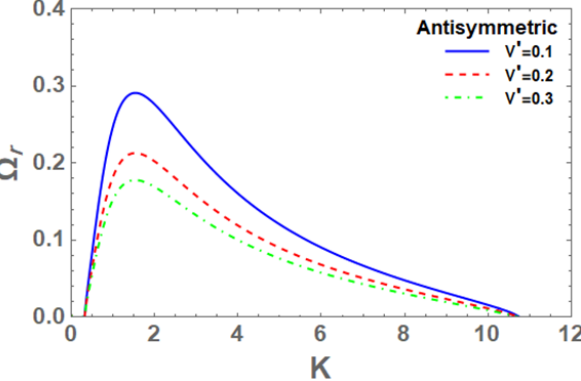
Figure 5. Non-dimensional growth rate Ω r and non-dimensional wave number K for different values of viscoelastitily parameter V (cid:48) , when We = 1000; Oh = 0.1; ρ = 0.01; N = 1; v = 0.2; κ 1 = 2; ˜ (cid:101) l = 0.3; ˜ (cid:101) g = 0.1; U = 1.5; ε = 0.5, for axisymmetric disturbance case.